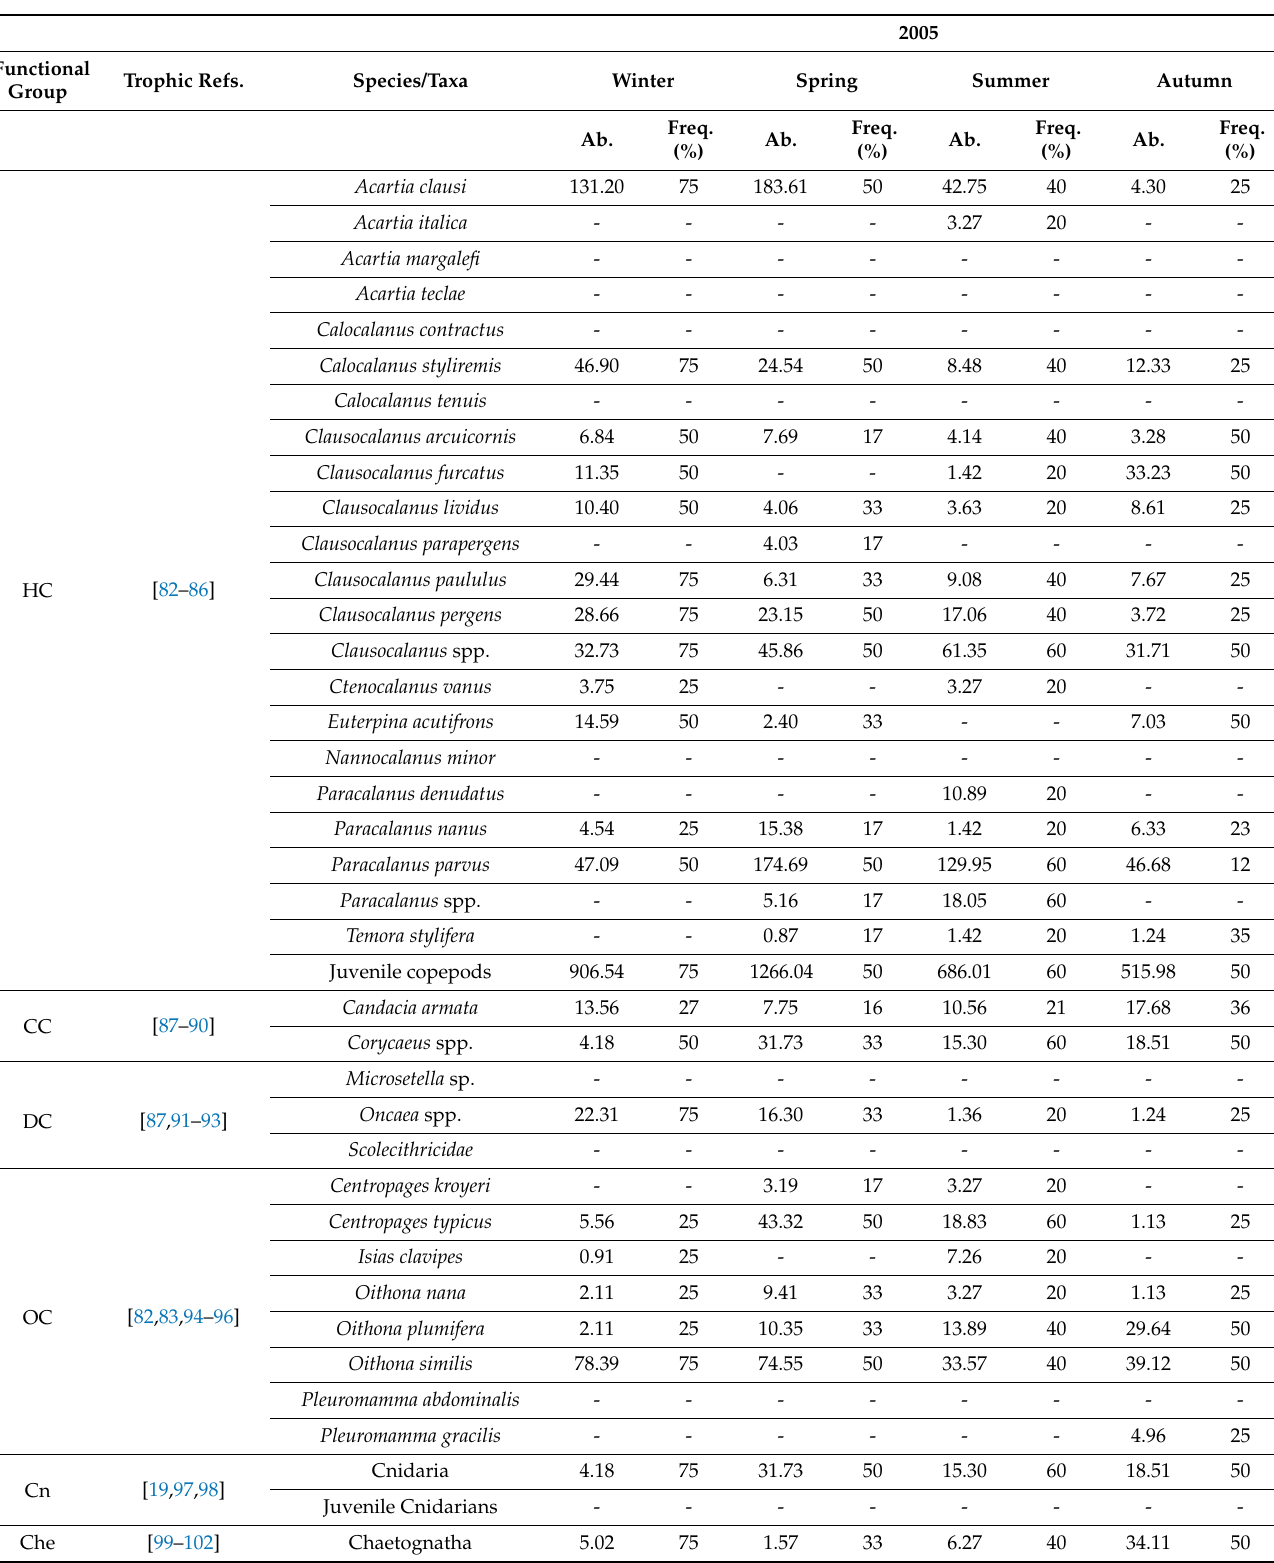
Table A5. Abundance and frequency of species in 2005 samplings.